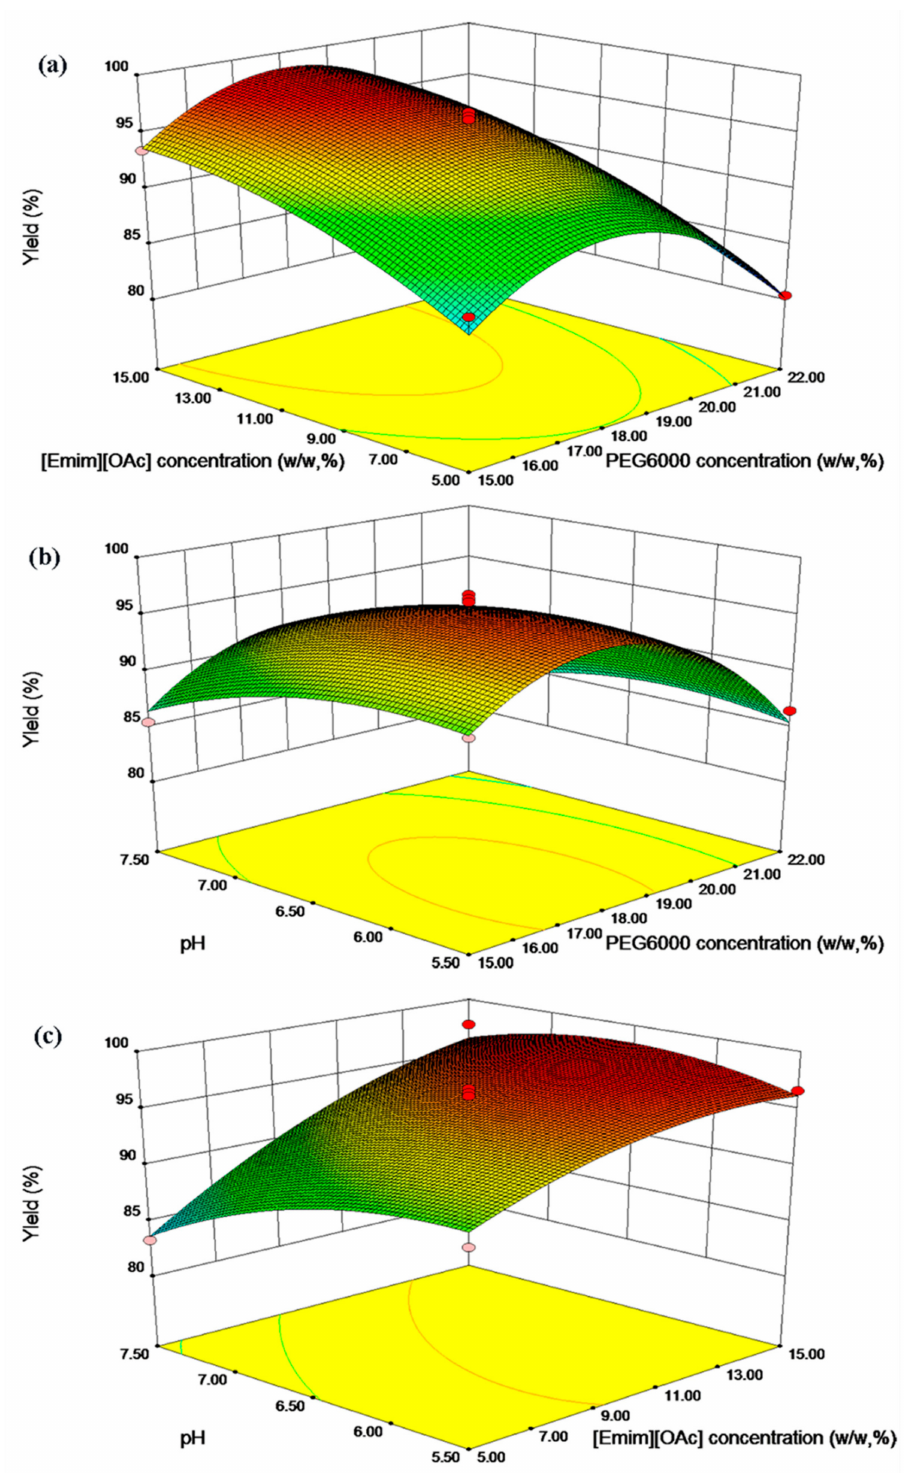
Figure 3. The response surface plot were shown as follows: ( a ) The e ff ect of the concentration [Emim] [OAC] and PEG6000 on the response at pH 6.5. ( b ) The e ff ect of the concentration of PEG6000 and pH on the response when the [Emim] [OAC] concentration was 10% ( w / w ). ( c ) The e ff ect of the pH and concentration of [Emim] [OAC] on the response when the PEG6000 concentration was 18.5% ( w / w